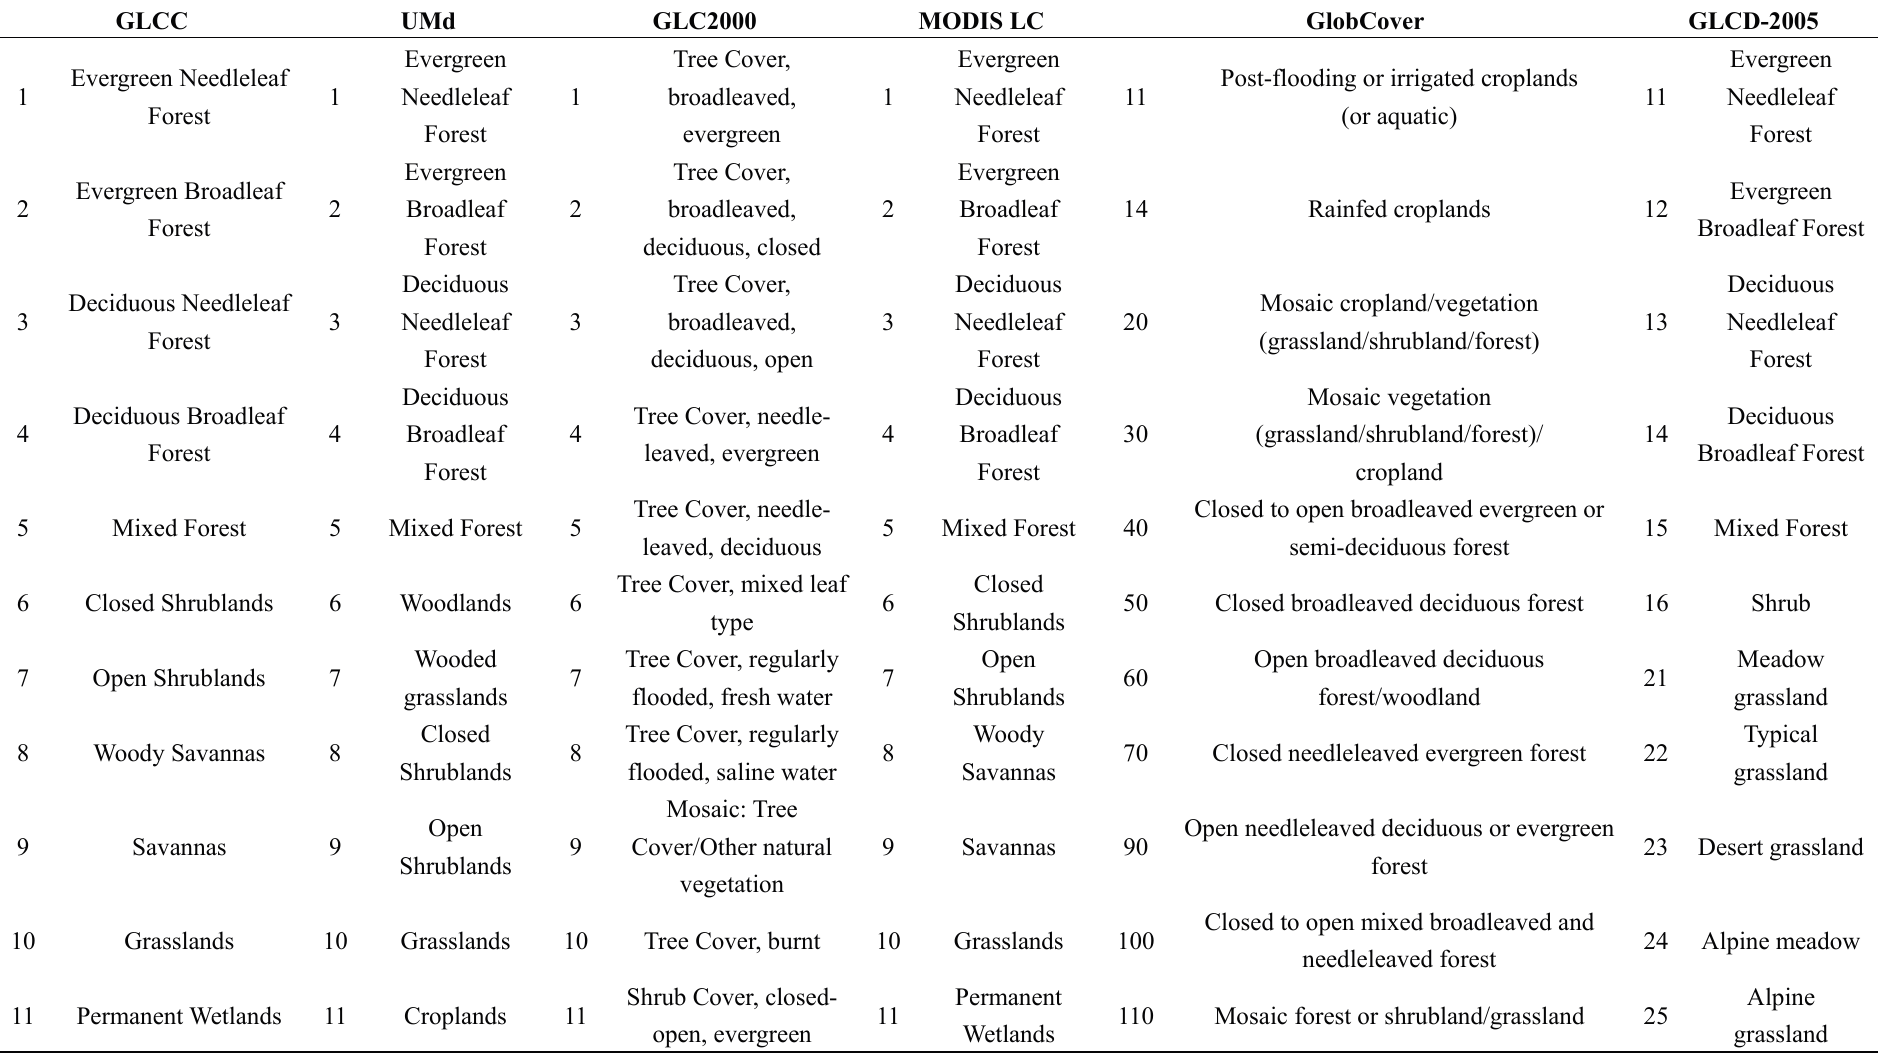
Table 3. The original classification schemes of compared land cover data